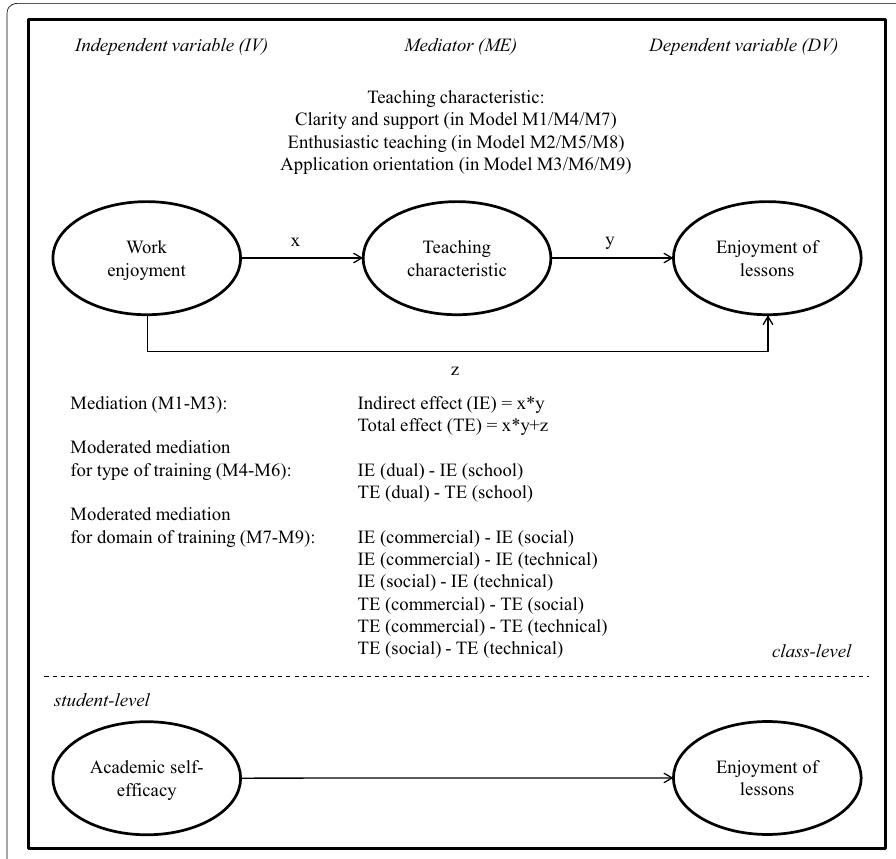
Fig. 1 Overview of specified mediation and moderated mediation